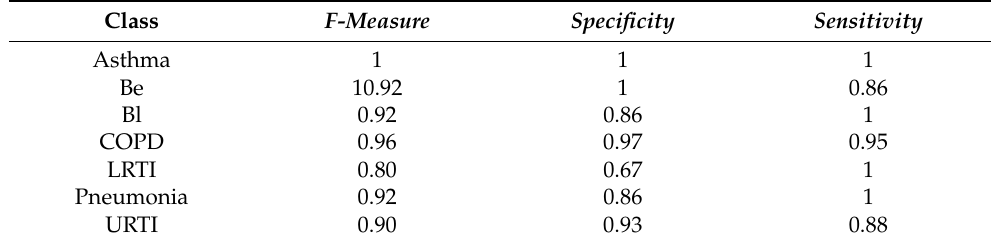
Table 4. Lung disease characterisation classification result from the single disease. We use the Be and Bl notations to indicate bronchiectasis and bronchiolitis pulmonary disease, respectively.